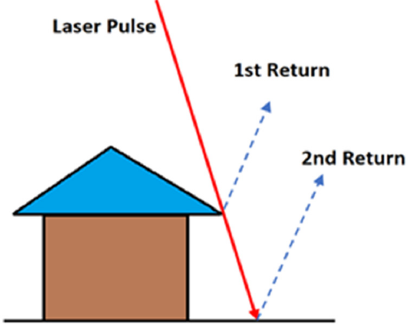
Figure 3. Examples of multiple returns. An emitted laser pulse causes two returns, corresponding to two different LiDAR points. One is for eaves; the other one is for ground.